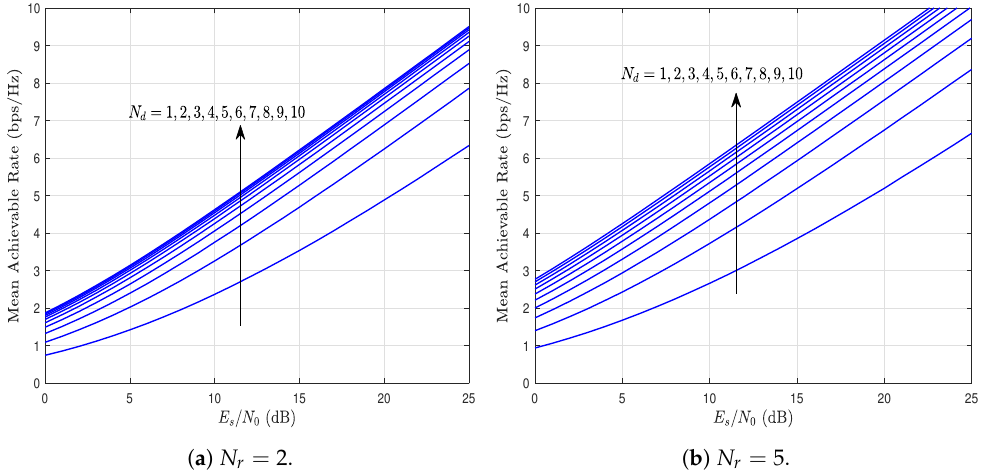
Figure 10. Mean achievable rate as a function of E s / N 0 , parameterized by N r , and N d considering k r = 1.5, k d = 0.9, λ r = 1.4, and λ d = 1.